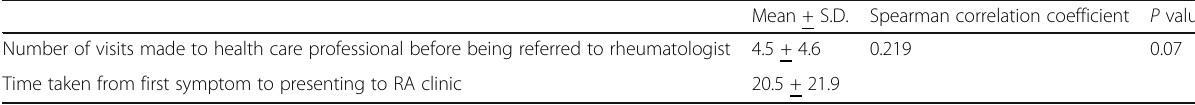
Mean + S.D. Spearman correlation coefficient P value